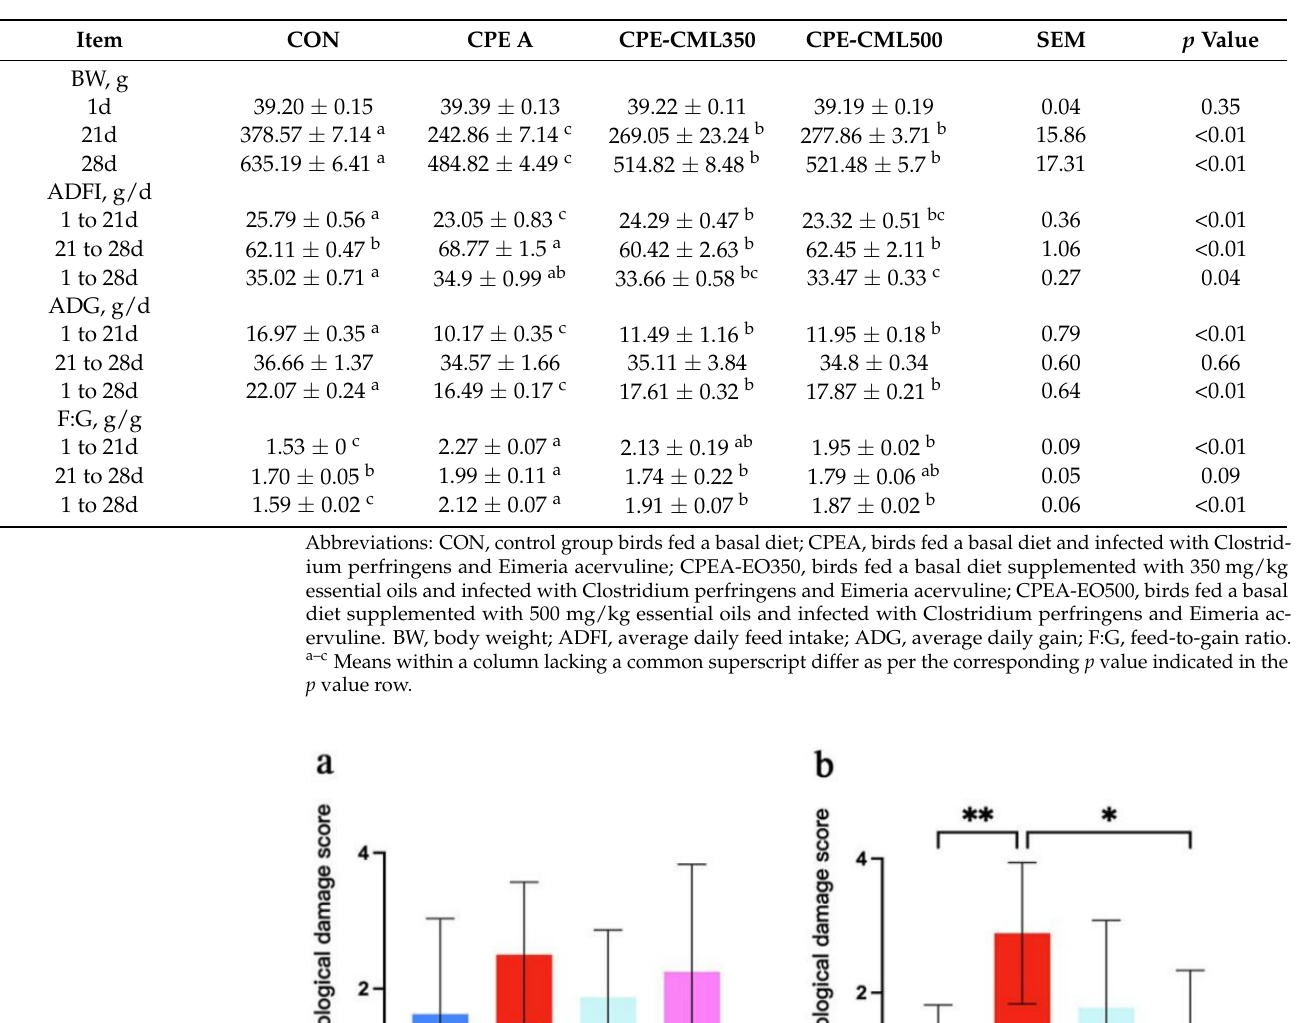
Table 3. The growth performance of broilers.